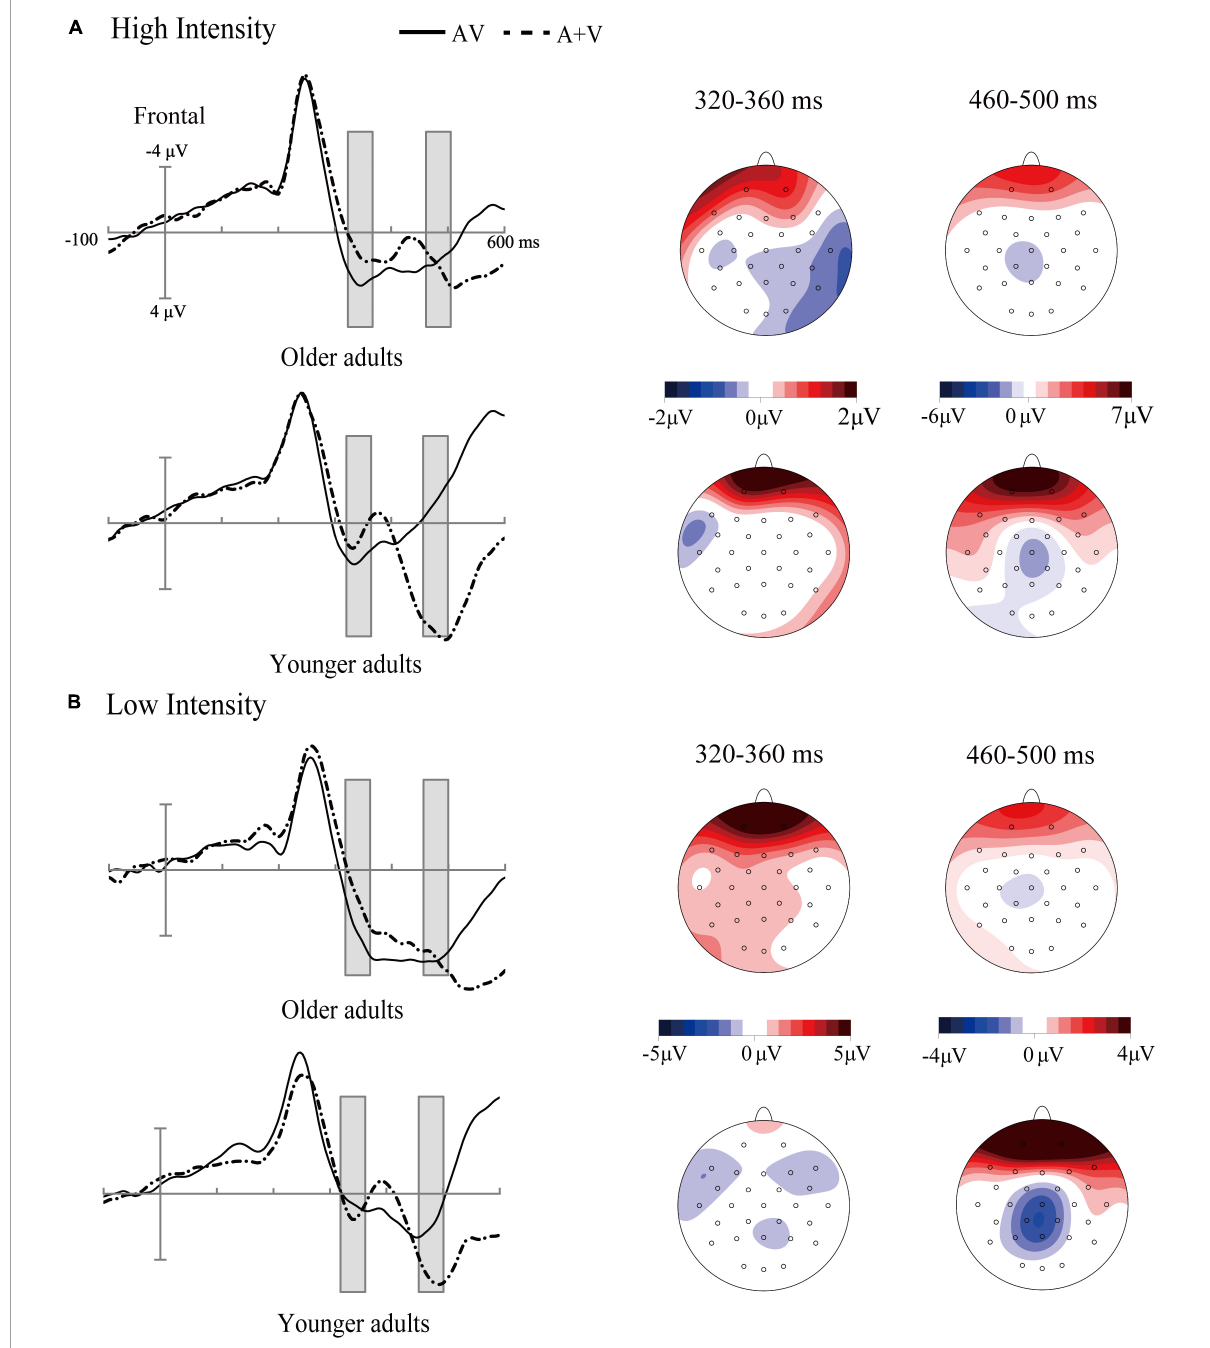
FIGURE5 Grand-average event-related potentials of audiovisual stimuli (AV) and the sum of visual and auditory stimuli (A + V) from 100 ms before the stimuli to 600 ms after stimulus onset as well as the topographic map of audiovisual integration [AV–(A + V)] in different age groups under high-intensity (A) and low-intensity conditions (B) . The gray cubes represent the integration time windows at 320–360 ms relative to auditory onset and 460–500 ms relative to auditory onset, illustrating the difference in audiovisual integration between older and younger adults.